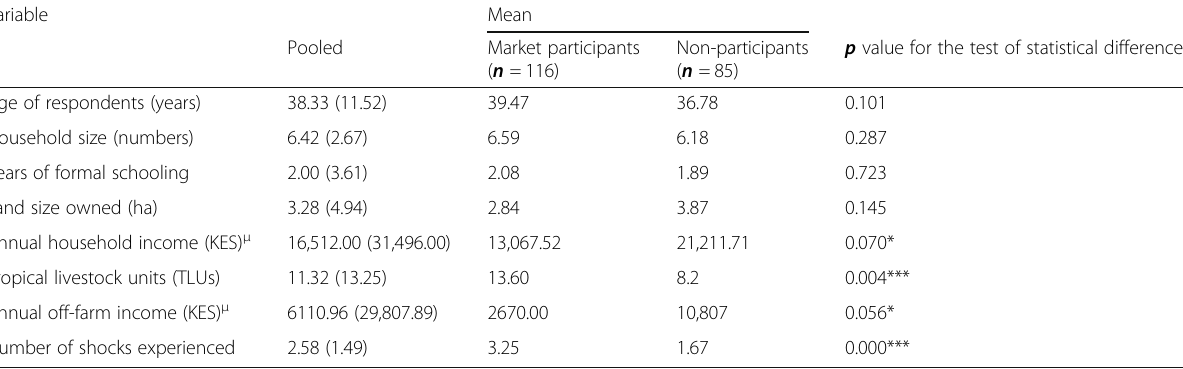
Table 1 Respondents ’ socio-economic characteristics